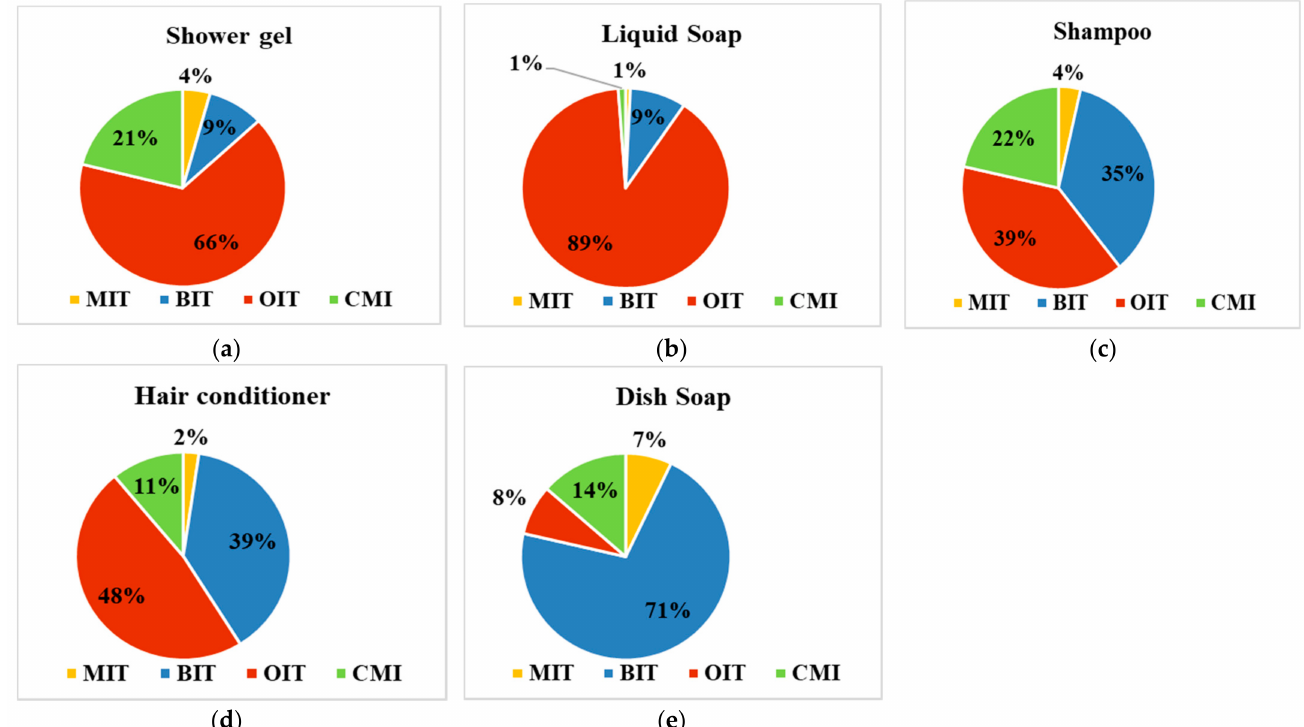
Figure 1. Percentage of biocide compounds in commercial products: ( a ) shower gel, ( b ) liquid soap, ( c ) shampoo, ( d ) hair conditioner, and ( e ) dish